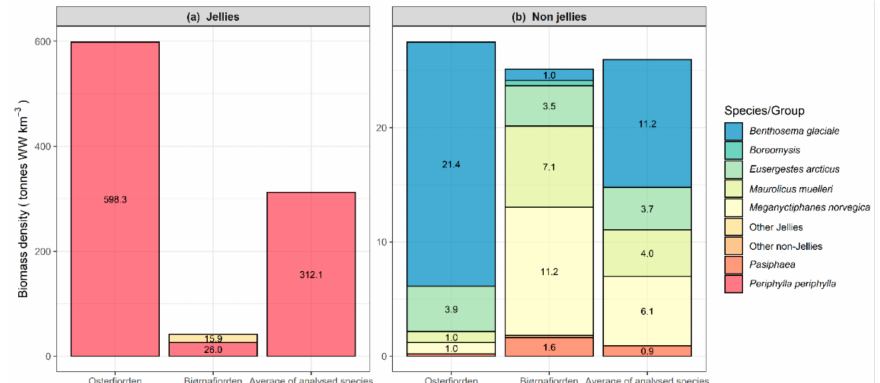
Figure 2. Biomass density of mesopelagic species in Norwegian fjords. Biomass density of mesopelagic species / groups in Osterfjorden and Bjørnafjorden in December 2018 from oblique trawls with macroplankton trawls with either 35 or 350 m 2 opening area. The fjords contained most of the same species; however, their contribution to the total ecosystem varied greatly. ( a ) The jellyfish Periphylla periphylla in Osterfjorden and Bjørnafjorden and an average of the 2 fjords. ( b ) Mesopelagic species, without jellies, in Osterfjorden and Bjørnafjorden, and an average of the 5 other species mentioned in this paper. Table 1. Overview of analyzed samples. Number of composite samples including number of specimens in each sample and the average length or weight of the specimens (mean ± SD) from Osterfjord, Bjørnafjord and Boknafjord (December 2018) is given.